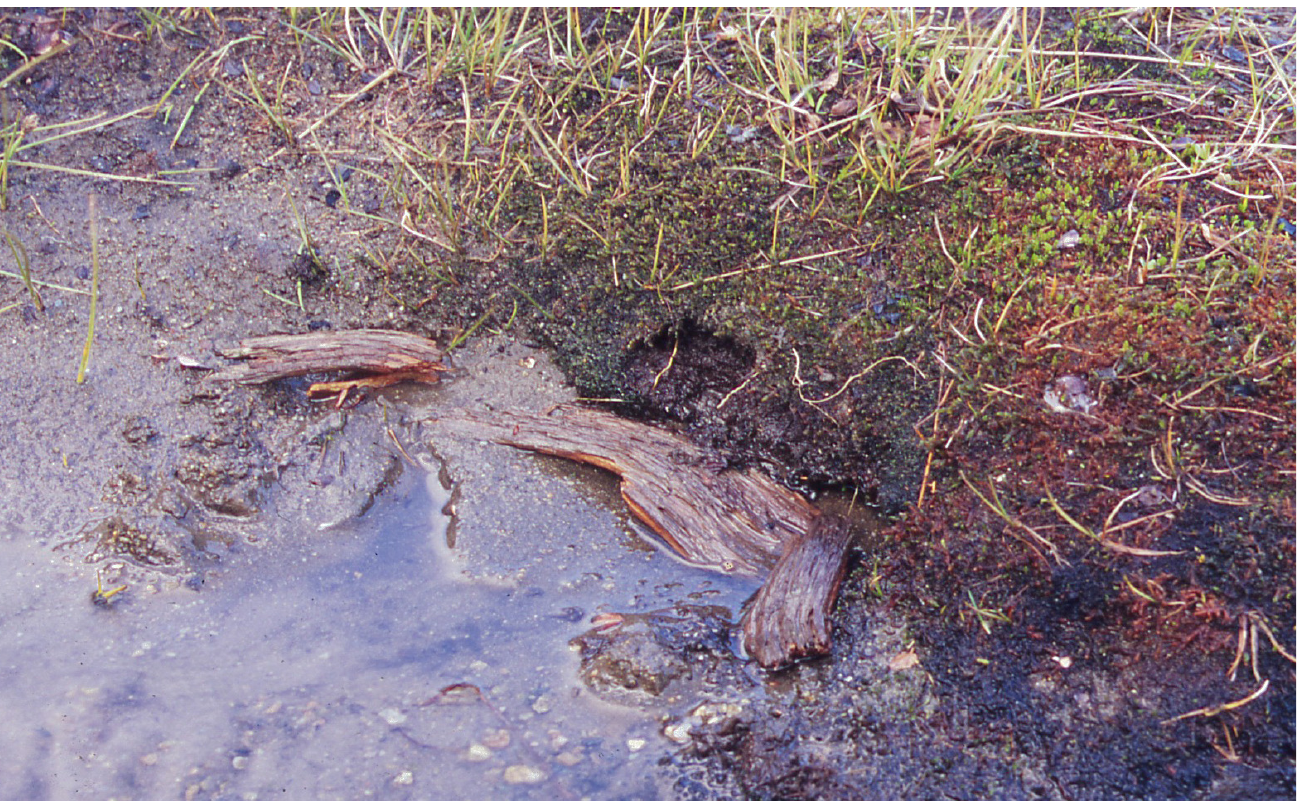
Figure 25: Helagsglaciären (1). Subfossil remnants of pine, dating to the Late Glacial, recovered in the lower reaches of the glacier forefield.